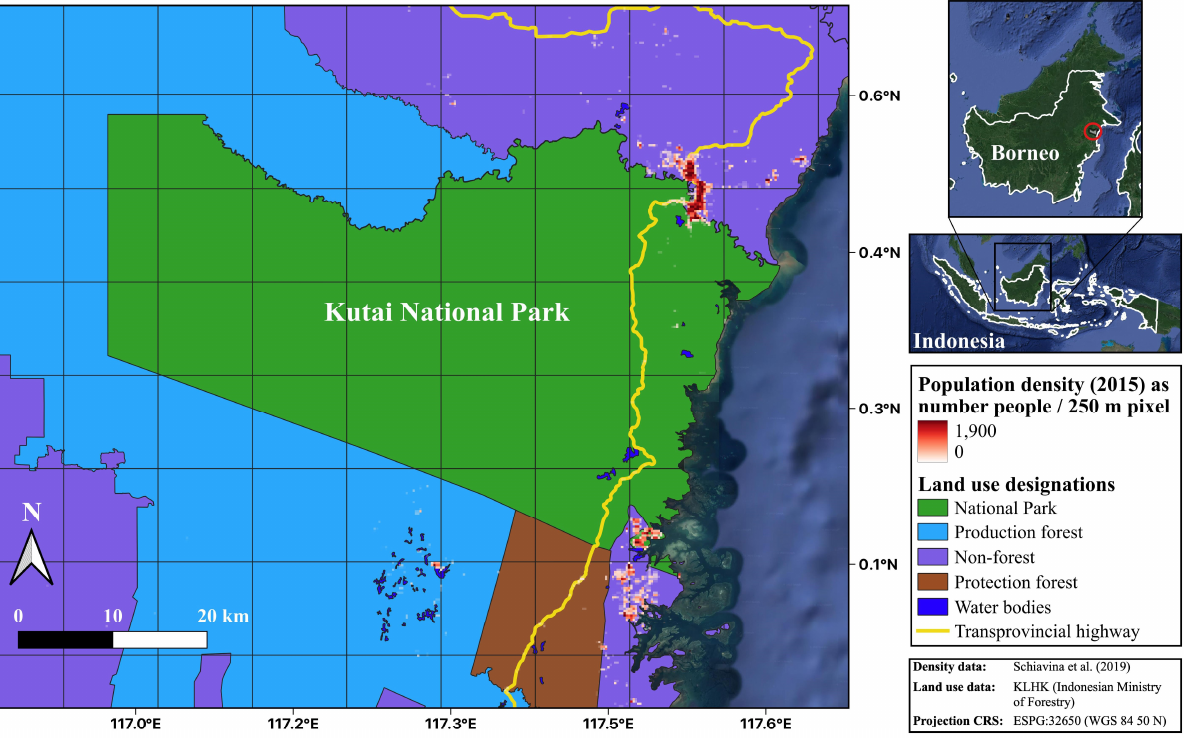
Figure 1. Land use designations and population density within and around Kutai National Park of East Kalimantan, Indonesia. Density displayed as estimated number of people per 250 m × 250 m grid cell [22] Southeastern and northeastern population centers represent the respective cities of Bontang and